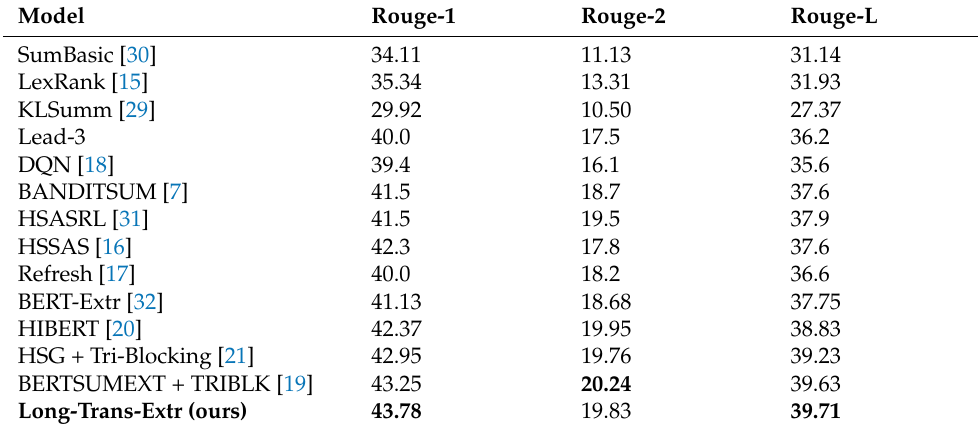
Table 2. The experimental results of Long-Trans-Extr and other methods on the CNN/DailyMail datasets.